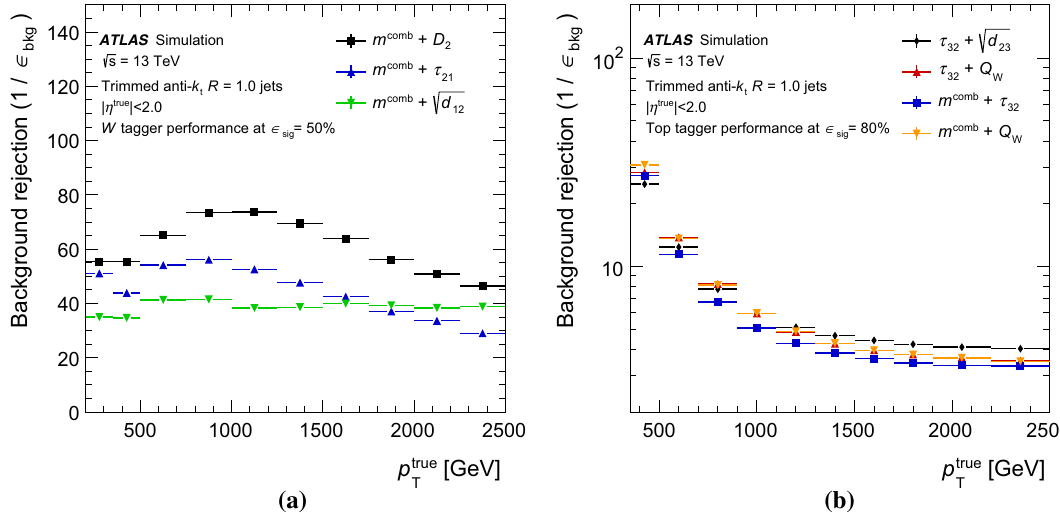
Fig. 2 The W -boson ( a ) and top-quark tagging ( b ) background rejection as a function of jet p true at fixed signal